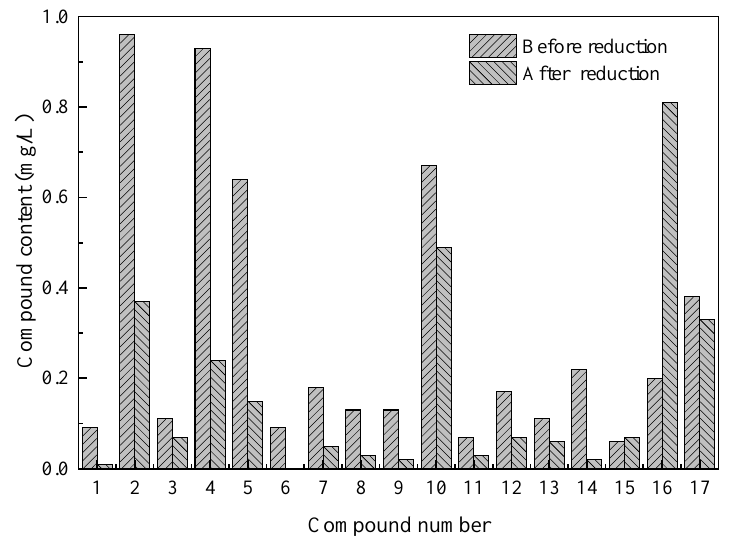
Figure 7. Contents of certain compounds (listed below) before and after reduction (1 — C 8 H 10 ; 2 —